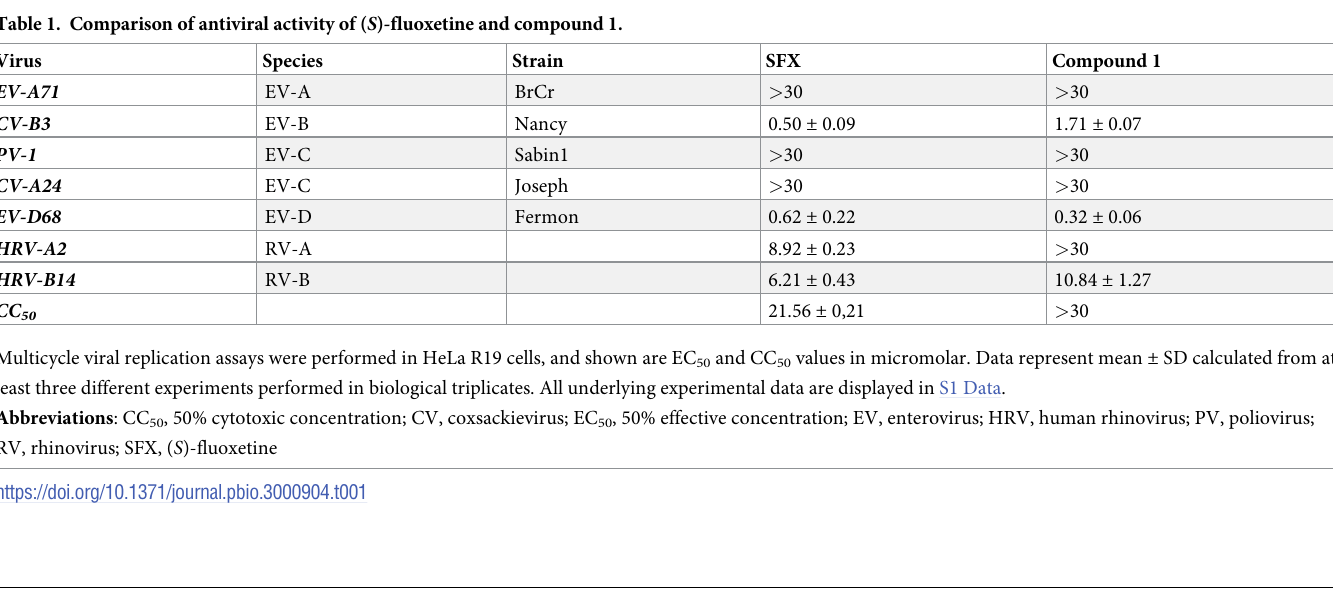
Table 1. Comparison of antiviral activity of ( S )-fluoxetine and compound 1. Virus